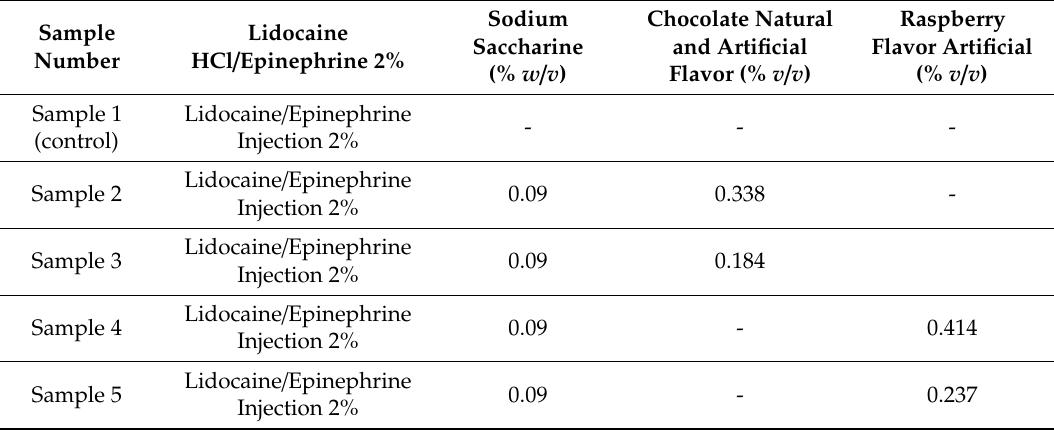
Table 3. Composition of various test samples for taste analysis using electronic tongue